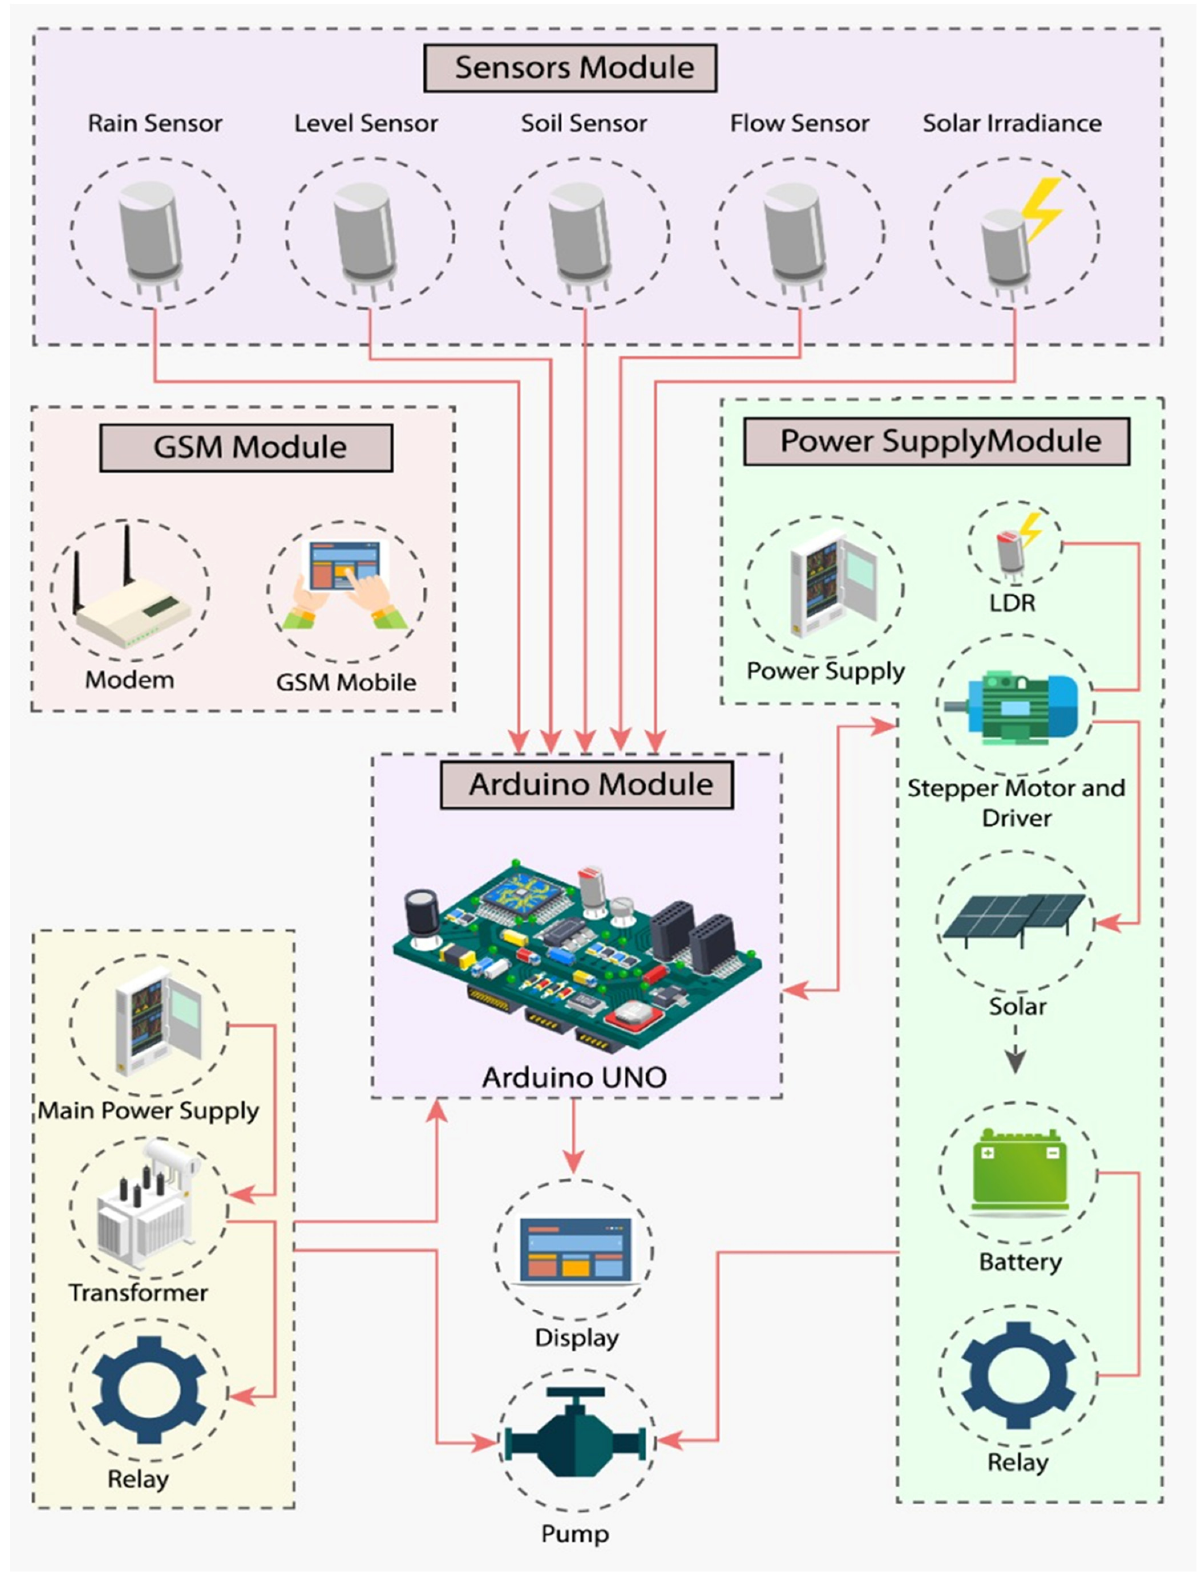
Figure 1. Schematic diagram of developed smart sensors based solar powered system for smart ir- Figure rigation.